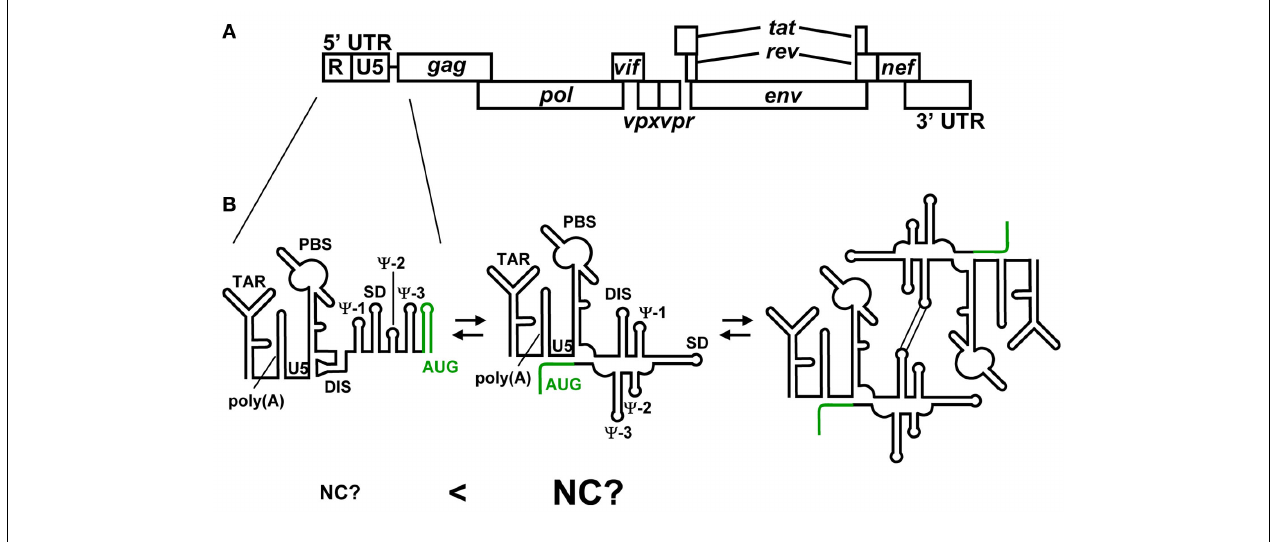
with the residues of U5. It has been suggested that HIV-2 genome’s dimerization is employed the same mechanism as HIV-1. However, it remains to be clear whether NC preferentially binds the 5 (cid:2) leader RNA containing the U5–AUG